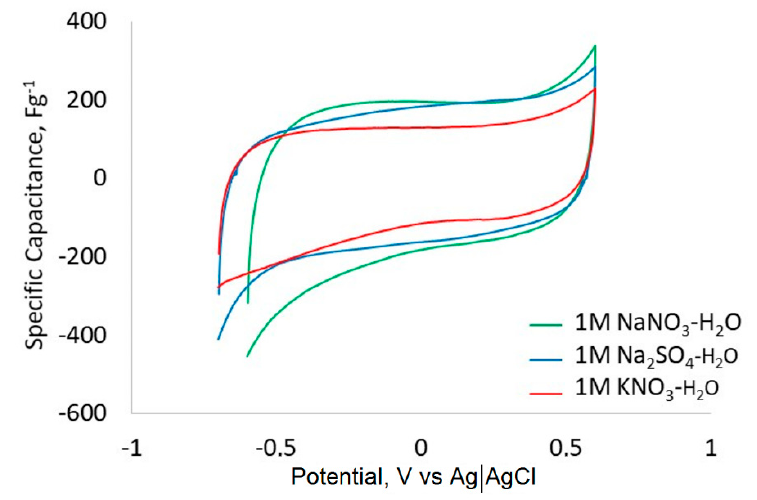
Figure 5. Cyclic voltammograms expressed as capacitance per CDC weight in fibrous electrodes in 1 M aqueous electrolytes ( v = 20 mV s − 1 ).